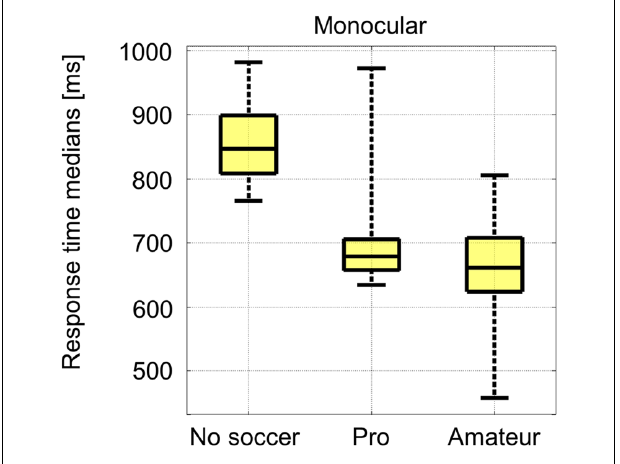
FIGURE 2 | Response time medians for the monocular